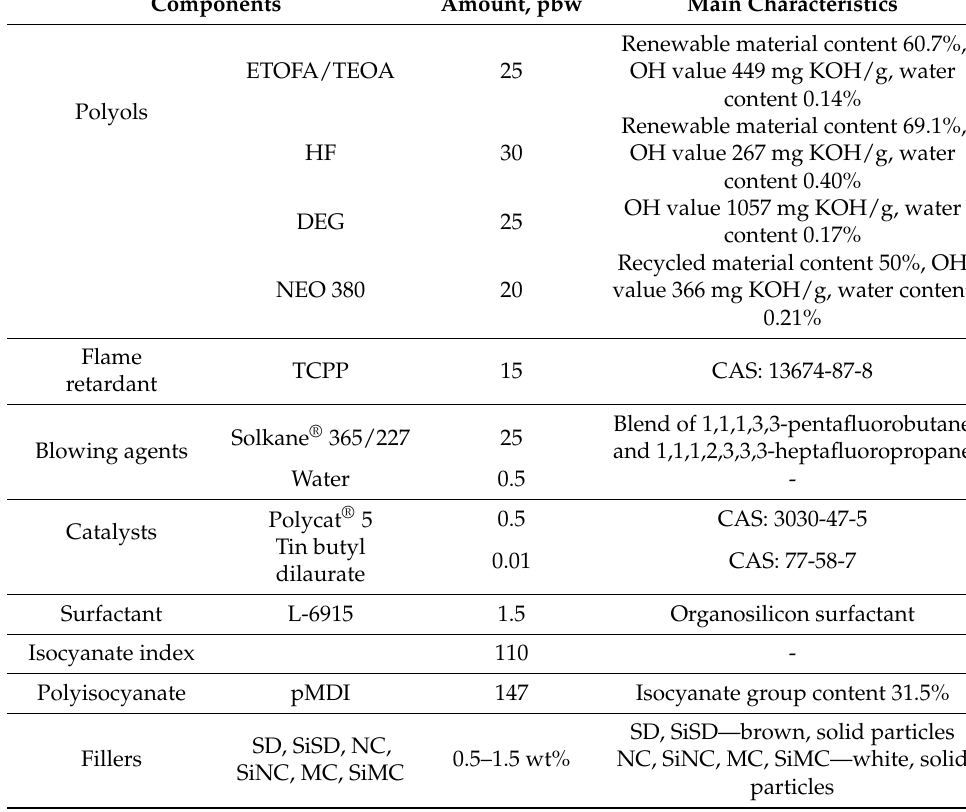
Table 1. Rigid PU formulation PP40